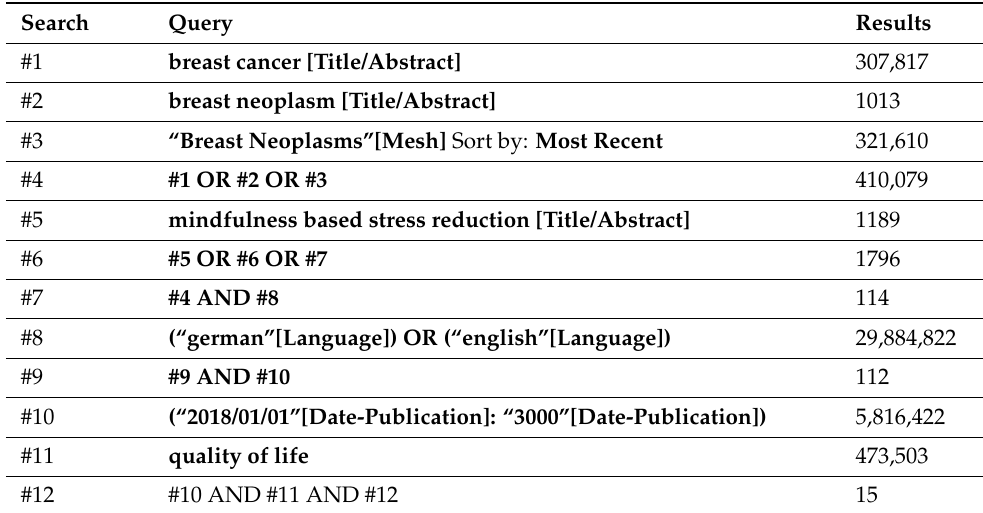
Table 2. Search Strategy; 6 March 2022 14:05 via PubMed